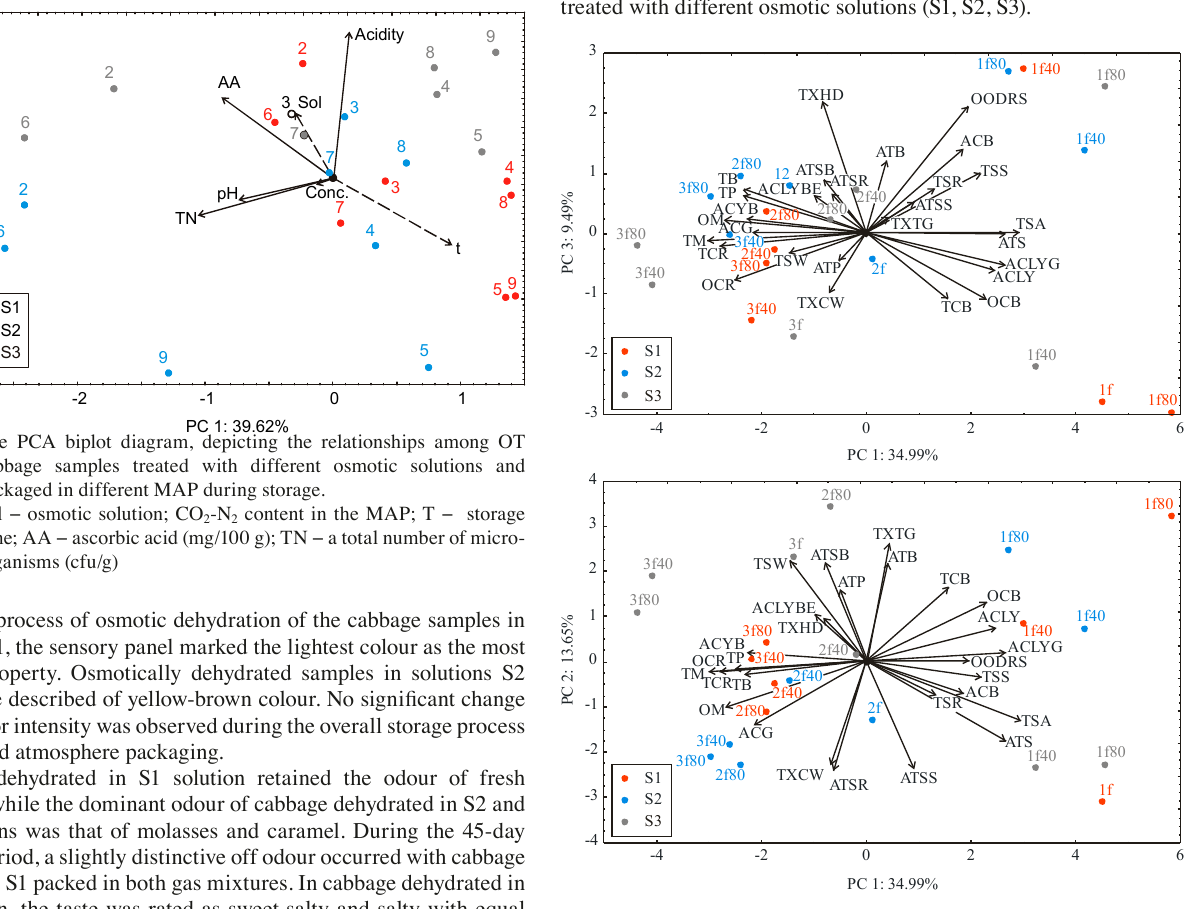
Fig. 2: The PCA biplot diagram, depicting the sensory analysis of OT cabbage samples treated with different osmotic solutions during storage. ACLY-appearance-colour- light yellow, ACLYG -appearance- colour- light yellow green, ACLYBE-appearance colour light yellow brown edges, ACYB-appearance colour yellow brown, ACB- appearance colour brown, ACG-appearance colour grey, OM-odour molasses, OCR-odour caramel, OCB-odour cabbage,